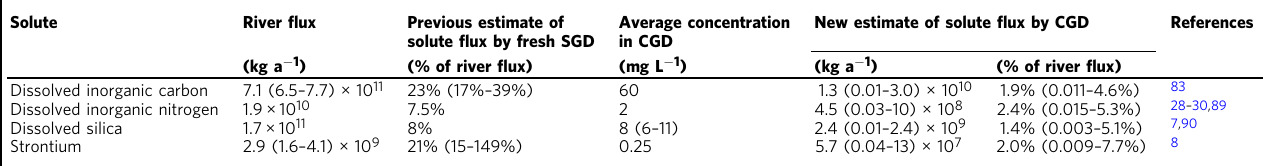
Table 1 Comparison of published and new values of the calculated solute fl ux to the oceans by rivers and coastal groundwater